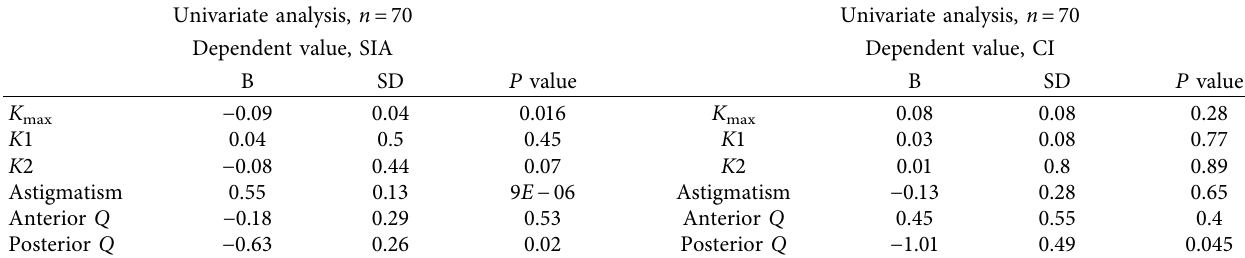
Table 2: Univariate analysis for corneal parameters for SIA and CI.